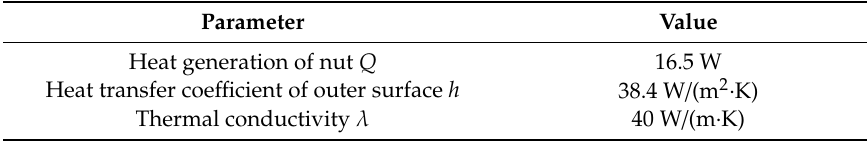
Table 2. Thermal parameters of ball screw.